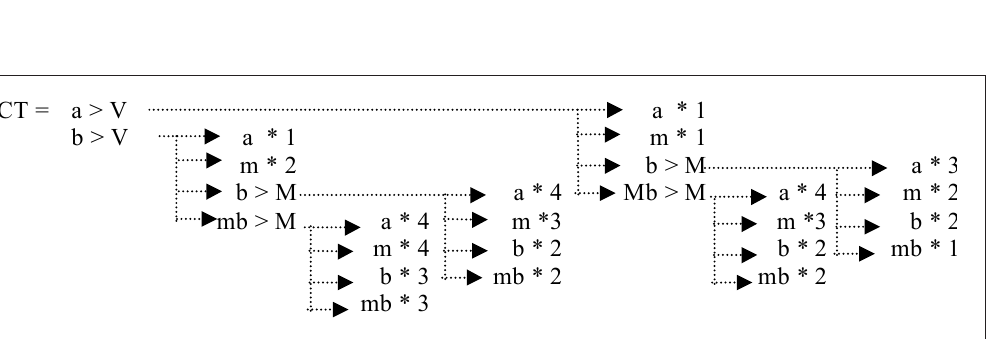
Figura 2. Representação esquemática da árvore de decisão utilizada na avaliação do feijão, considerando o requerimento de uso da terra fertilidade natural. Em que: CT - capacidade de troca de cátions; V - saturação por bases; M - saturação por alumínio; a - alta; m - média; b - baixa; mb - muito baixa; *1 - limitação nula ou ligeira; *2 - limitação moderada; *3 - limitação forte; *4 - limitação muito